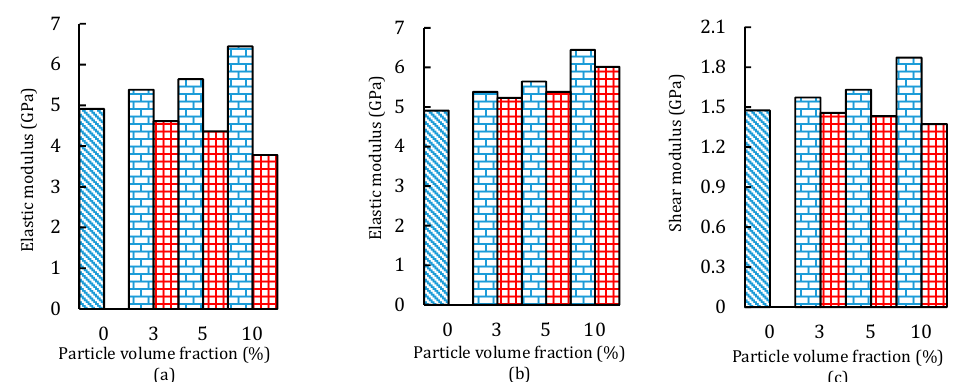
Figure 8. Effective elastic modulus of composite under ( a ) tensile, ( b ) compressive, and ( c ) shear loadings.